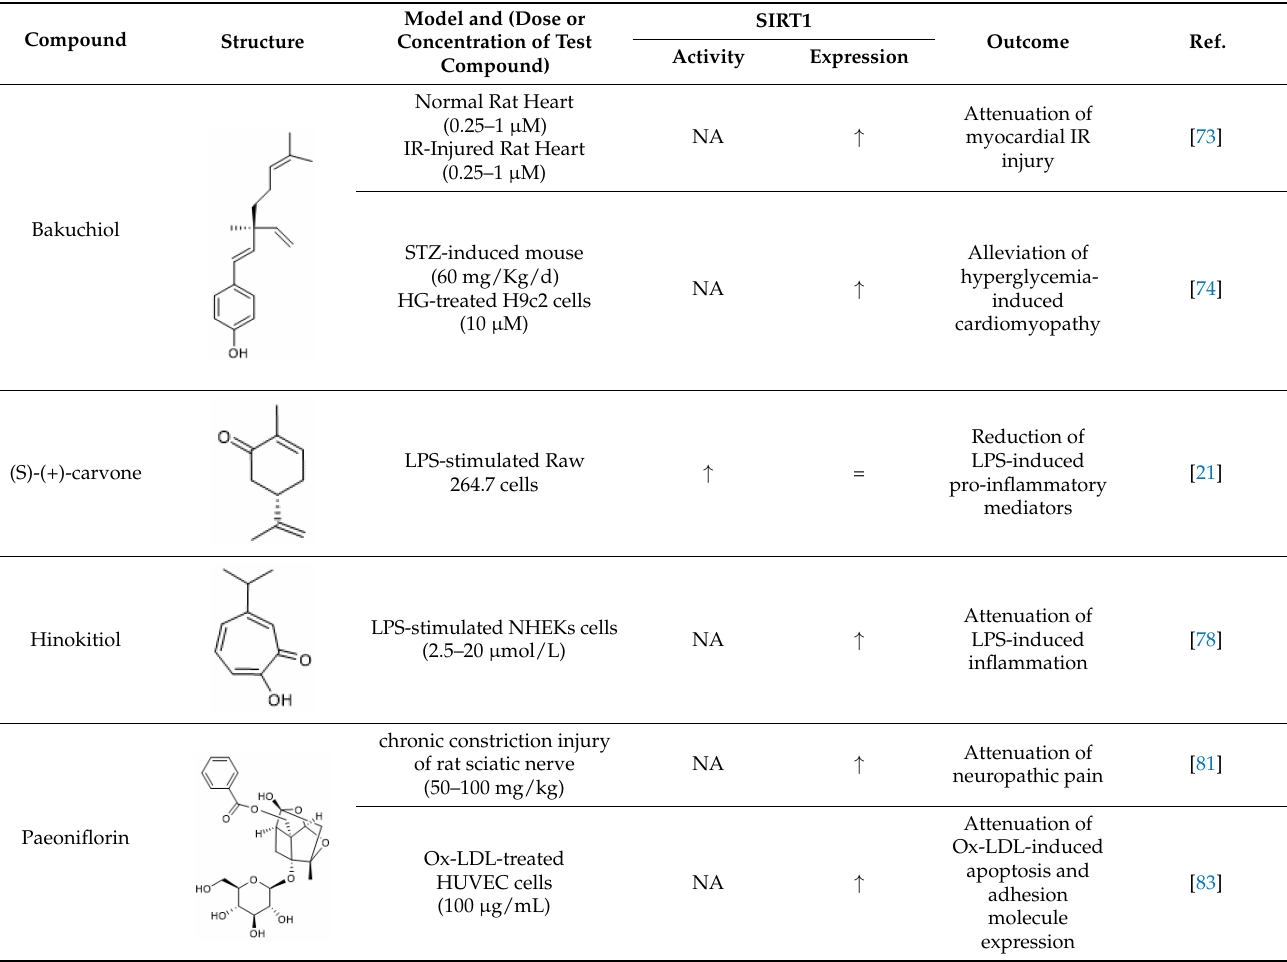
Table 1. Monoterpenes and